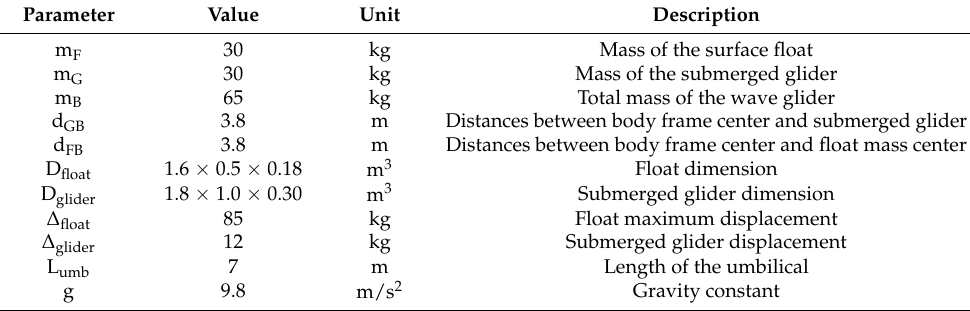
Table 1. Non-dynamic parameters of the “Black Pearl” wave glider.